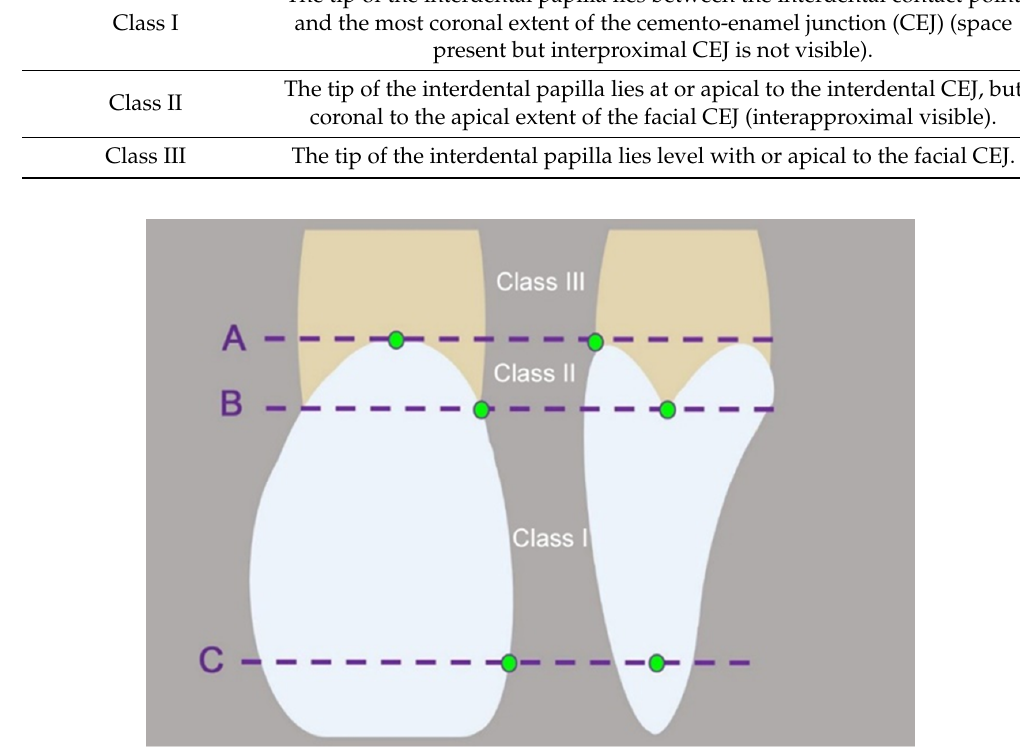
Table 2. Intraoral scanners used in this study.